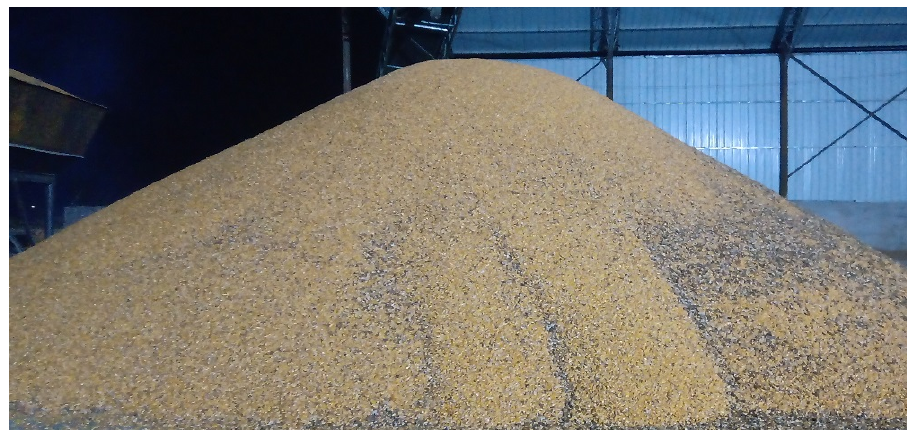
Figure 1. Fresh corn sample for the experiment.